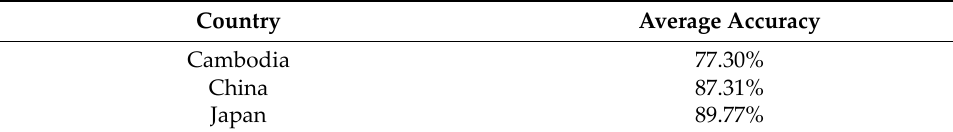
Table 6. Average accuracy of address quality of manufacturers by